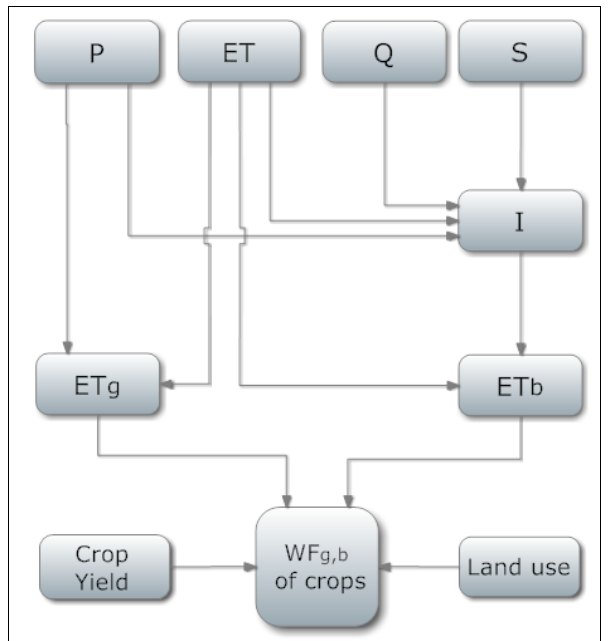
Figure 2. Flowchart proposed for obtaining WF of crops from remote sensing